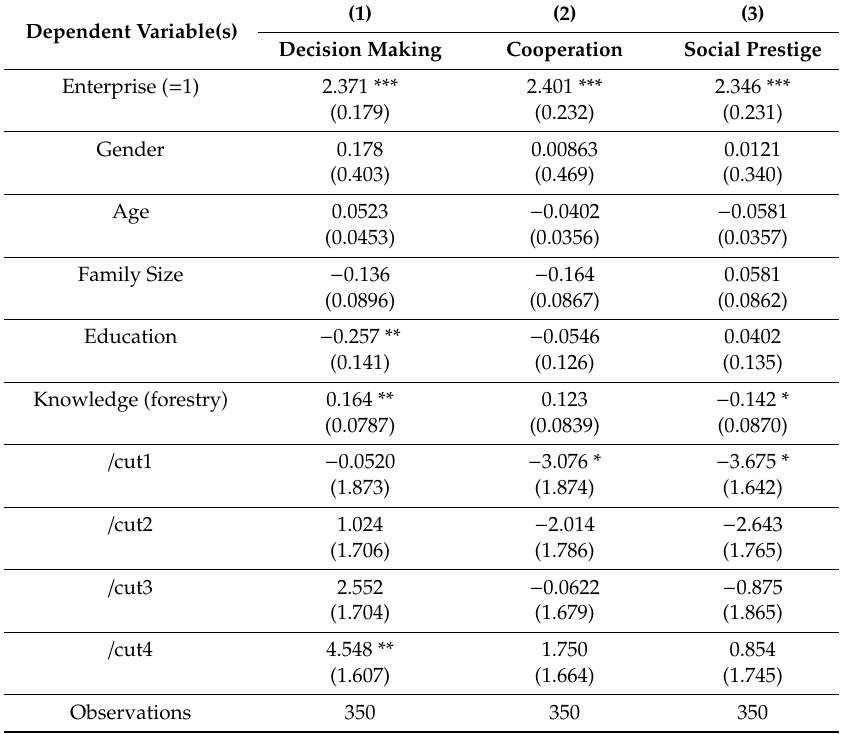
Table 8. BTAP and social